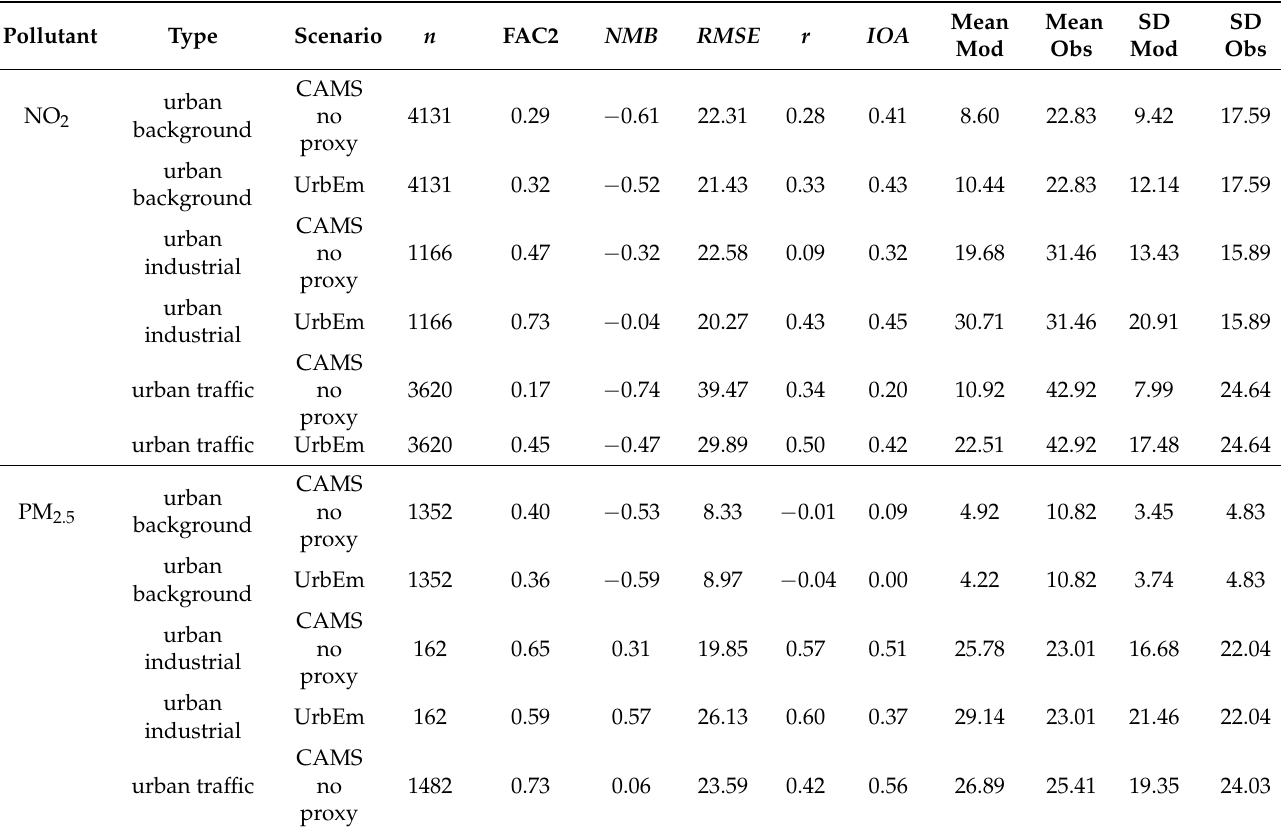
Table A3. Evaluation statistics for Athens. We aggregated all stations of the same type to groups of stations